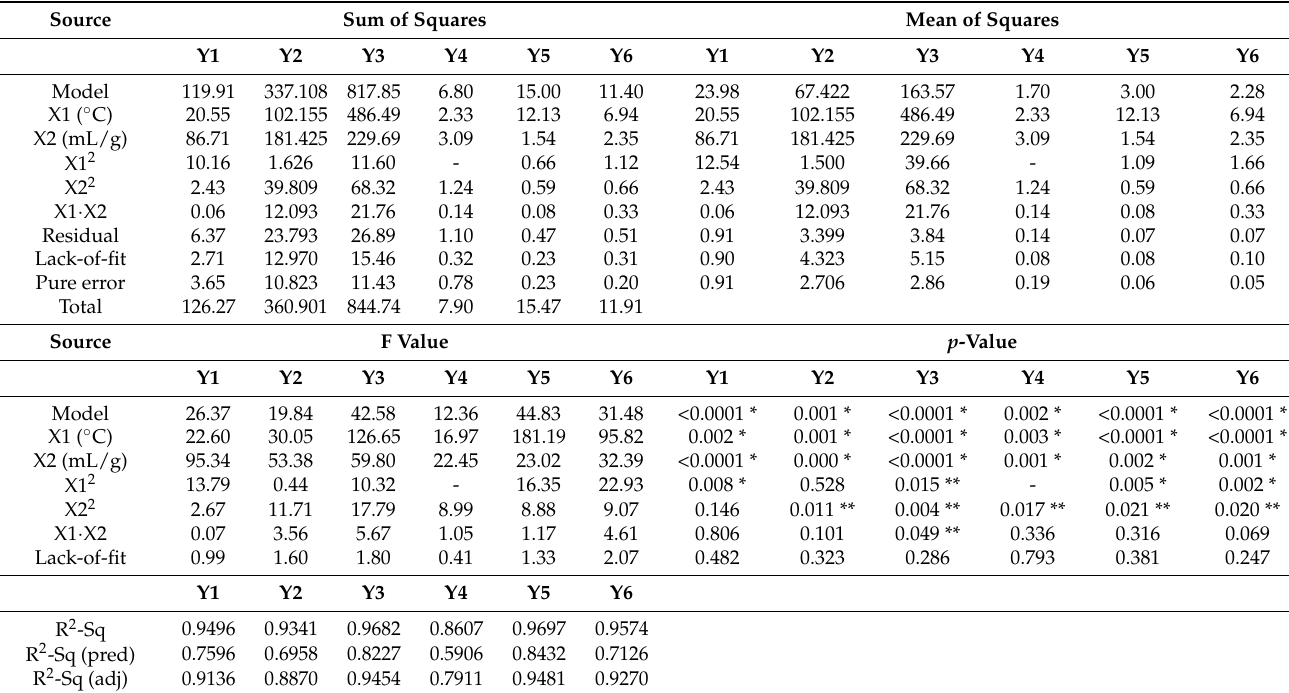
Table 3. Model summary and analysis of variance (ANOVA) of the effects of extraction conditions on the analyzed